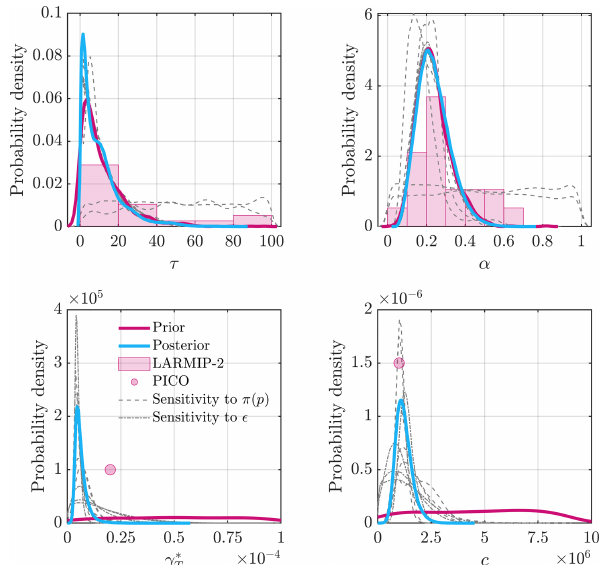
Figure B1. Results from our Bayesian analysis. Solid pink line shows priors using uniform bounds for γ ∗ and c and prior knowl- T edge from the LARMIP-2 distributions for τ and α (pink bars). Solid blue lines show the resultant posterior distributions using the pink lined priors. We performed a number of additional sensitiv- ity experiments in which we varied either the prior distributions (dashed grey line) or the likelihood function (solid grey line). The lines shown are the resultant posterior distributions. These show that our results are largely insensitive to our choice of priors (except in the case of uniform priors for τ and α , which given the information we have are unsuitable) or the likelihood function used. Pink circles show the values proposed for γ ∗ and c by Reese et al. (2018a) for T circum-Antarctic simulations using the PICO box model. Point esti- mates from our posterior probability distributions show our c value is close, while values of γ ∗ appear likely to be lower than the value T in